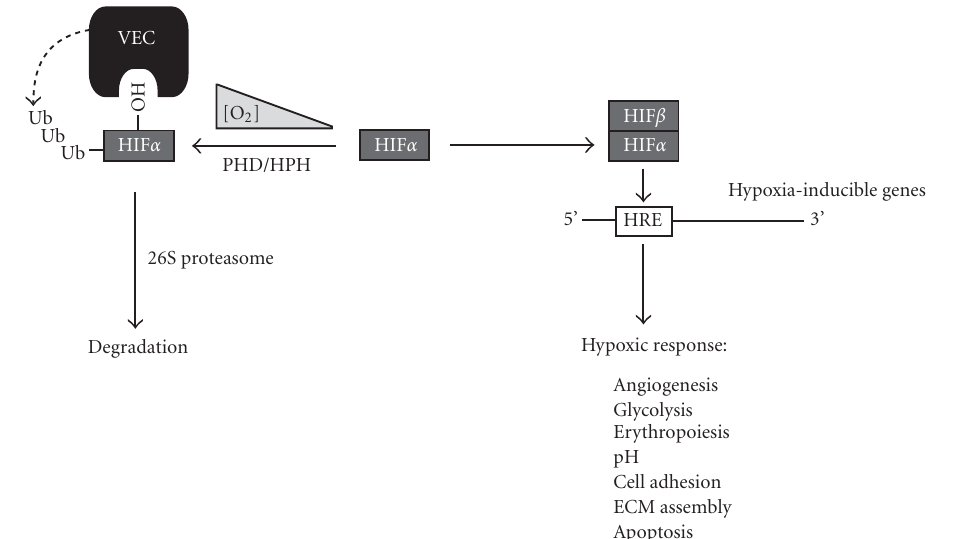
Figure 2. Oxygen-dependent gene regulation via the “VHL-pathway.” In the presence of dioxygen, iron, and oxoglutarate, prolyl hydroxylases PHD/HPH 1,2, and 3 hydroxylate the α subunit of HIF on proline residues 402 and 564. The hydroxylated HIF α subunit is recognized by the VEC complex for ubiquitylation. In reduced oxygen tension, HIF α is no longer hydroxylated and thereby escapes ubiquitin-mediated proteolysis. HIF β binds to the stable HIF α to form HIF, which promotes the transcriptional activation of numerous hypoxia-inducible genes (HIGs). Protein synthesis of HIGs results in various physiological responses to hypoxia. HRE represents hypoxia-responsive element; ECM represents extracellular